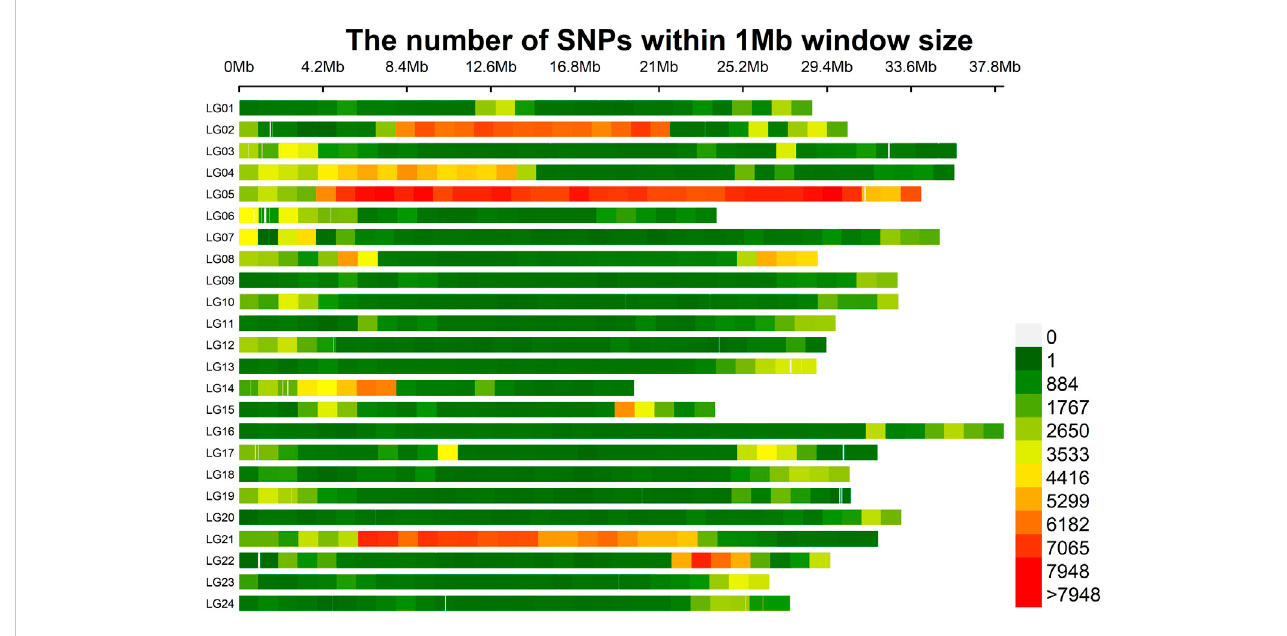
FIGURE 1 The distribution of SNPs on the chromosomes of mandarin fi sh genome.